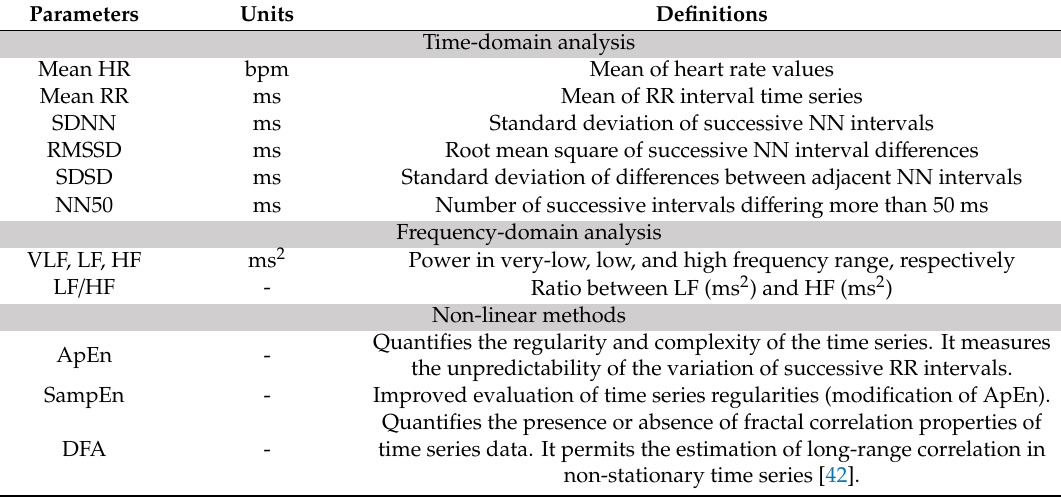
Table 1. Heart rate variability